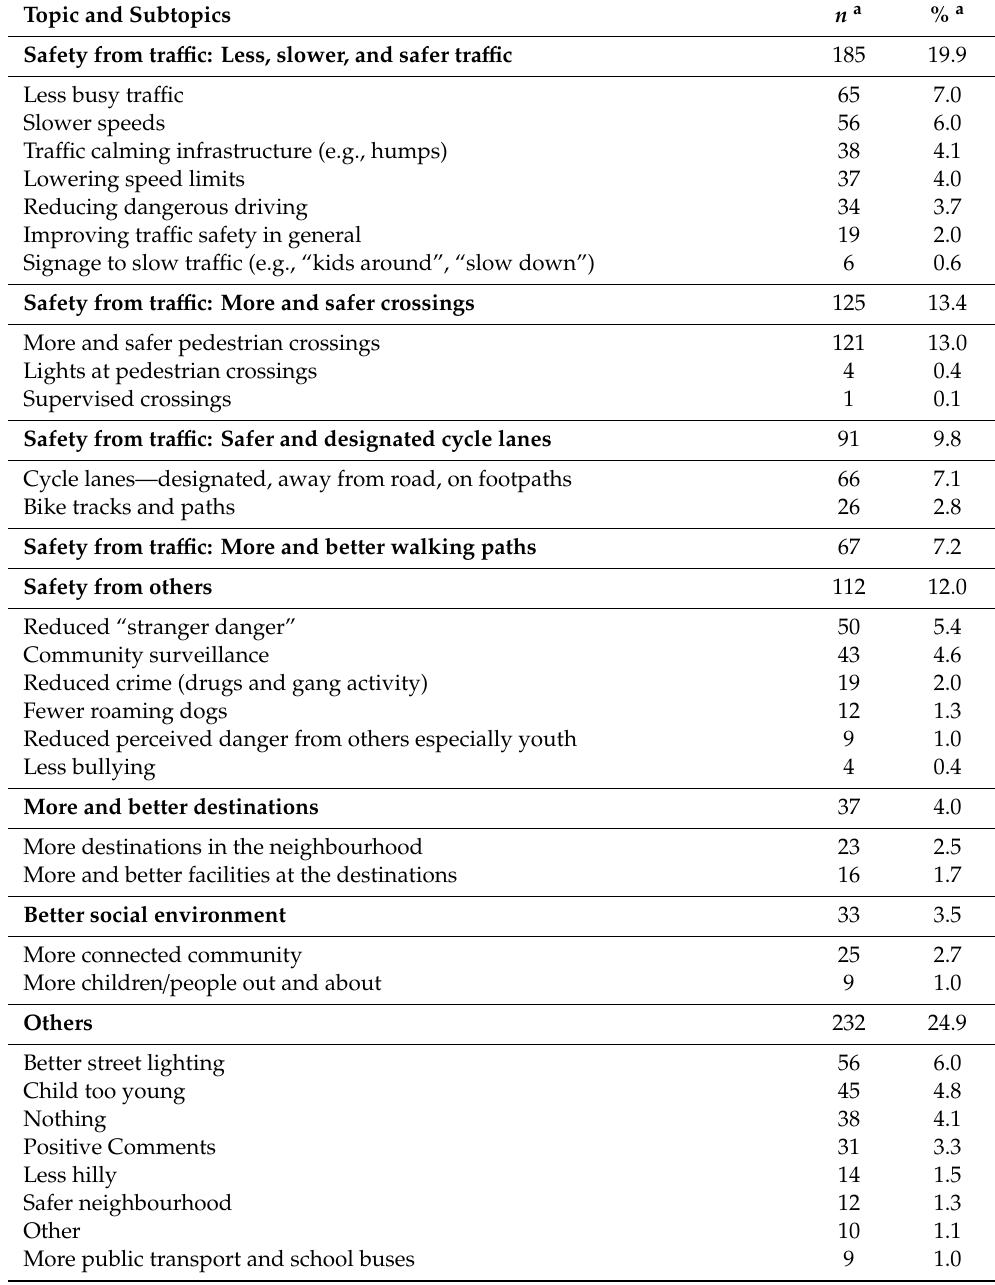
Table 2. Descriptive statistics for key topics derived from parent responses to the question “What would make your neighbourhood a better place for (Child Name) to walk, bike or scooter by (Himself / Herself)?” ( n =